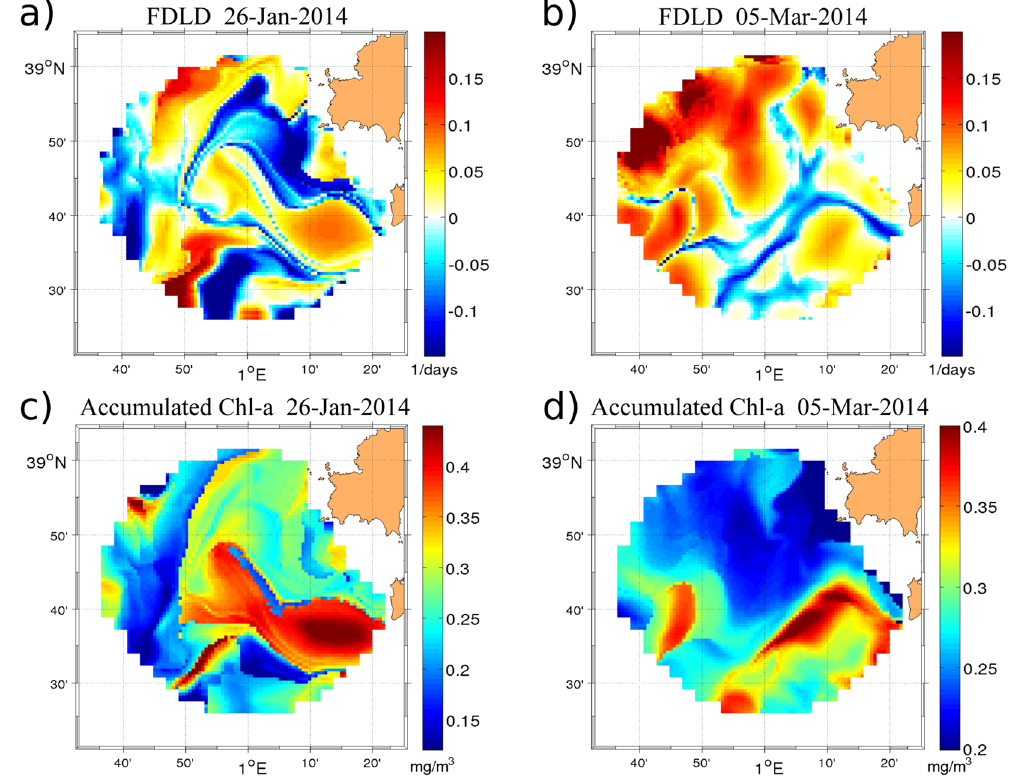
Figure 5. Top panel: Snapshots of FDLD (in days − 1 ) from HF Radar corresponding to ( a ) January 26, 2014, ( b ) March 5, 2014. Bottom panel: Accumulated Chl-a (in mg/m 3 ) computed for the same time instant that in top panels. ( c ) January 26, 2014, ( d ) March 5, 2014. The figure was made using MATLAB R2012a (http://www.